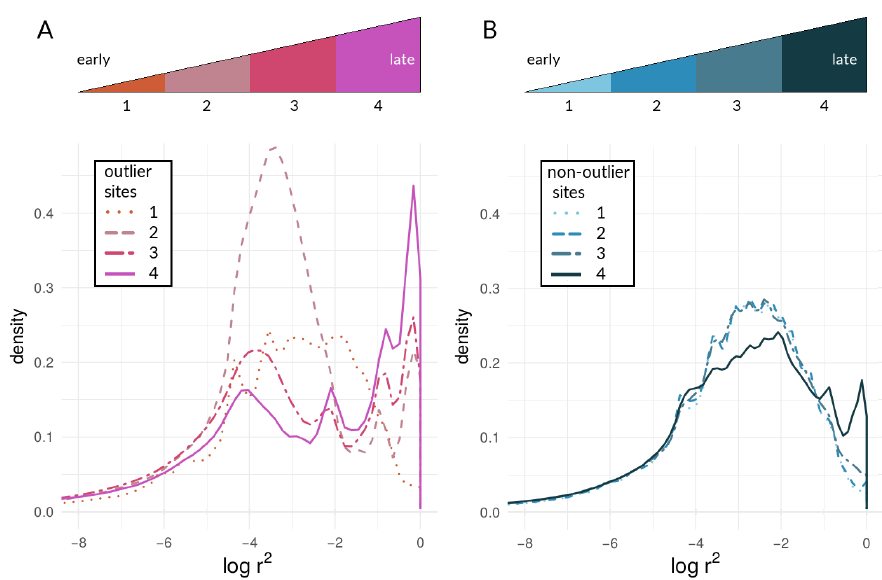
Figure 9. Density curves of within-species LD for ( A ) outliers and ( B ) non-outlier loci. Individual lines correspond to log ( r 2 ) values of (1) pachinus locus pairs for the comparison of c. galanthus and pachinus on Chromosome 2, (2) m. rosina locus pairs for the comparison of pachinus and m. rosina on Chromosome